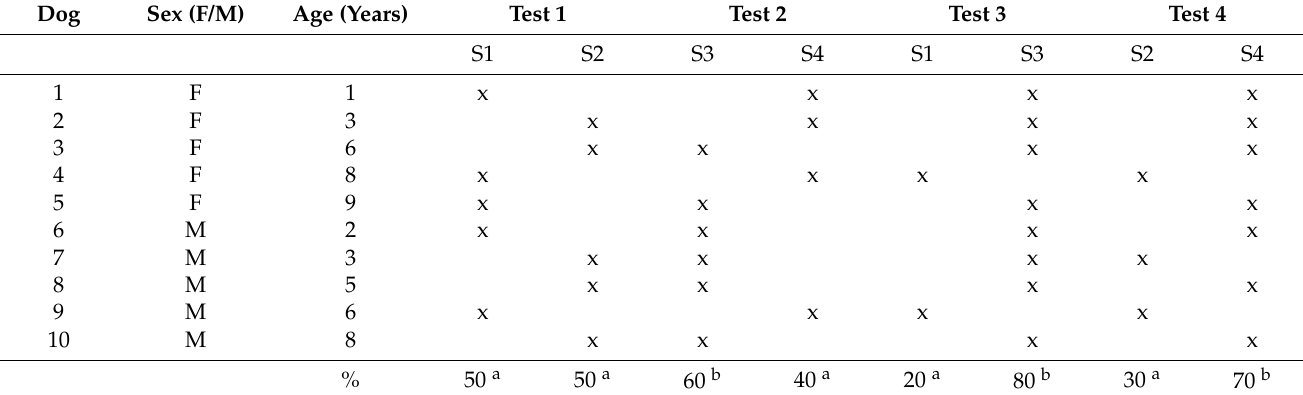
Table 6. Dog preferences in four palatability tests.